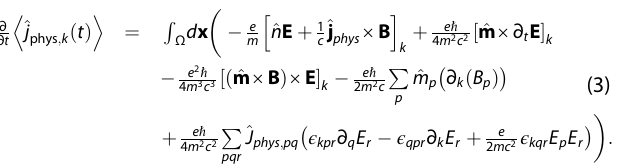
Fig. 7 Effect of SOC on the timing of the harmonic emission. Time- frequency analysis of the harmonic emission driven by a linearly- polarized laser fi eld, ( a ) with SOC, and ( b ) without SOC. The width of the Gabor transform is taken as a third of the period of the laser pulse, corresponding to a time of 0.37 fs. The time pro fi le of the driving laser fi eld is also shown as a solid